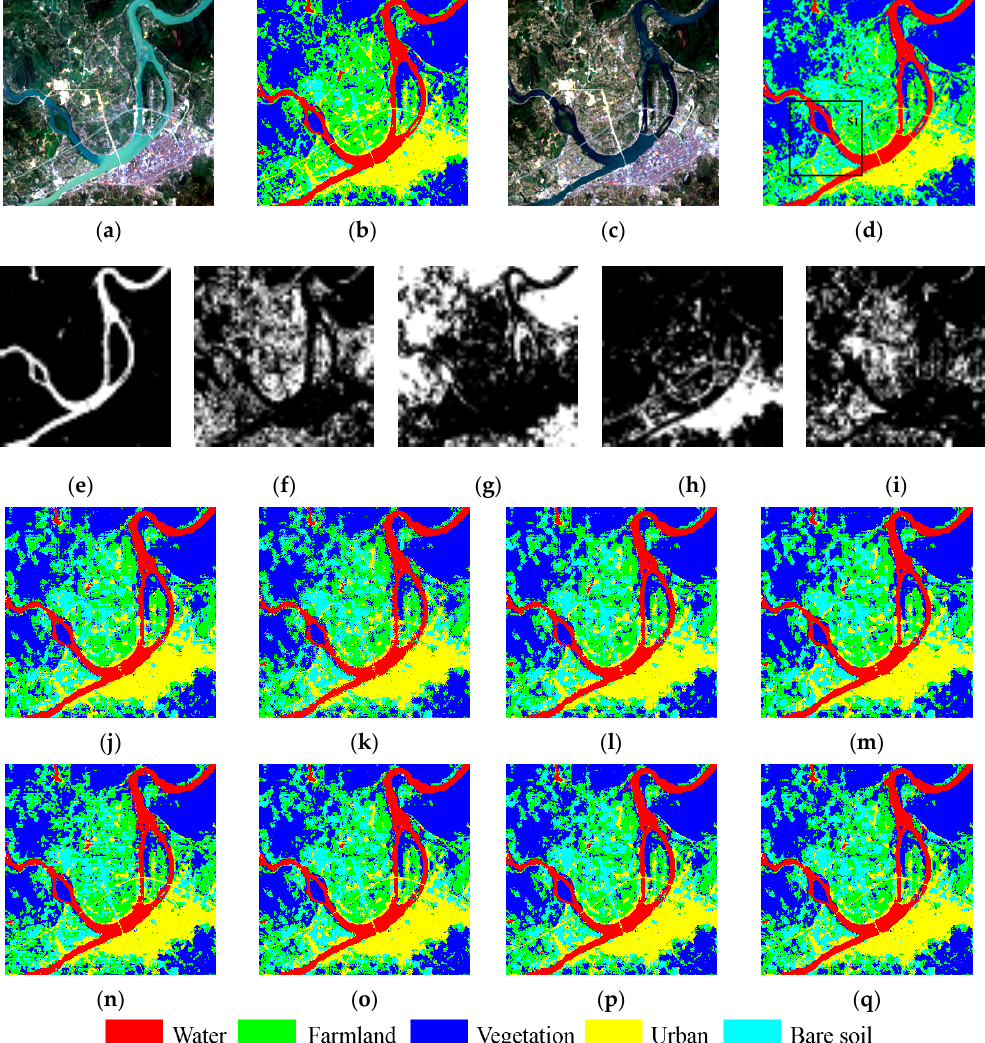
Figure 10. Sub-pixel mapping results for the Landsat 8 image in Experiment 1: ( a ) Original Landsat 8 image from 13 July 2013 (bands 4, 3, 2) (240 × 240); ( b ) Original SVM classification result of the 13 July 2013, Landsat 8 image (250 × 250); ( c ) Original Landsat 8 image from 7 August 2013 (bands 4, 3, 2) (240 × 240); ( d ) Original SVM classification result of the 7 August 2013, Landsat 8 image (250 × 250); ( e ) Fraction image of water (60 × 60); ( f ) Fraction image of farmland (60 × 60); ( g ) Fraction image of vegetation (60 × 60); (h) Fraction image of urban (60 × 60); (i) Fraction image of bare soil (60 × 60); ( j ) pixel swapping sub-pixel mapping (PSSM); ( k ) sub-pixel mapping based on a genetic algorithm (GASM); ( l ) sub-pixel mapping based on differential evolution (DESM); ( m ) sub-pixel mapping based on clonal selection (CSSM); ( n ) spatial-temporal sub-pixel mapping based on a pixel swapping algorithm (SSMPS); ( o ) spatial-temporal sub-pixel mapping based on a genetic algorithm (SSMGA); ( p ) spatial-temporal sub-pixel mapping based on differential evolution (SSMDE); and ( q ) spatial-temporal sub-pixel mapping based on clonal selection (SSMCS).